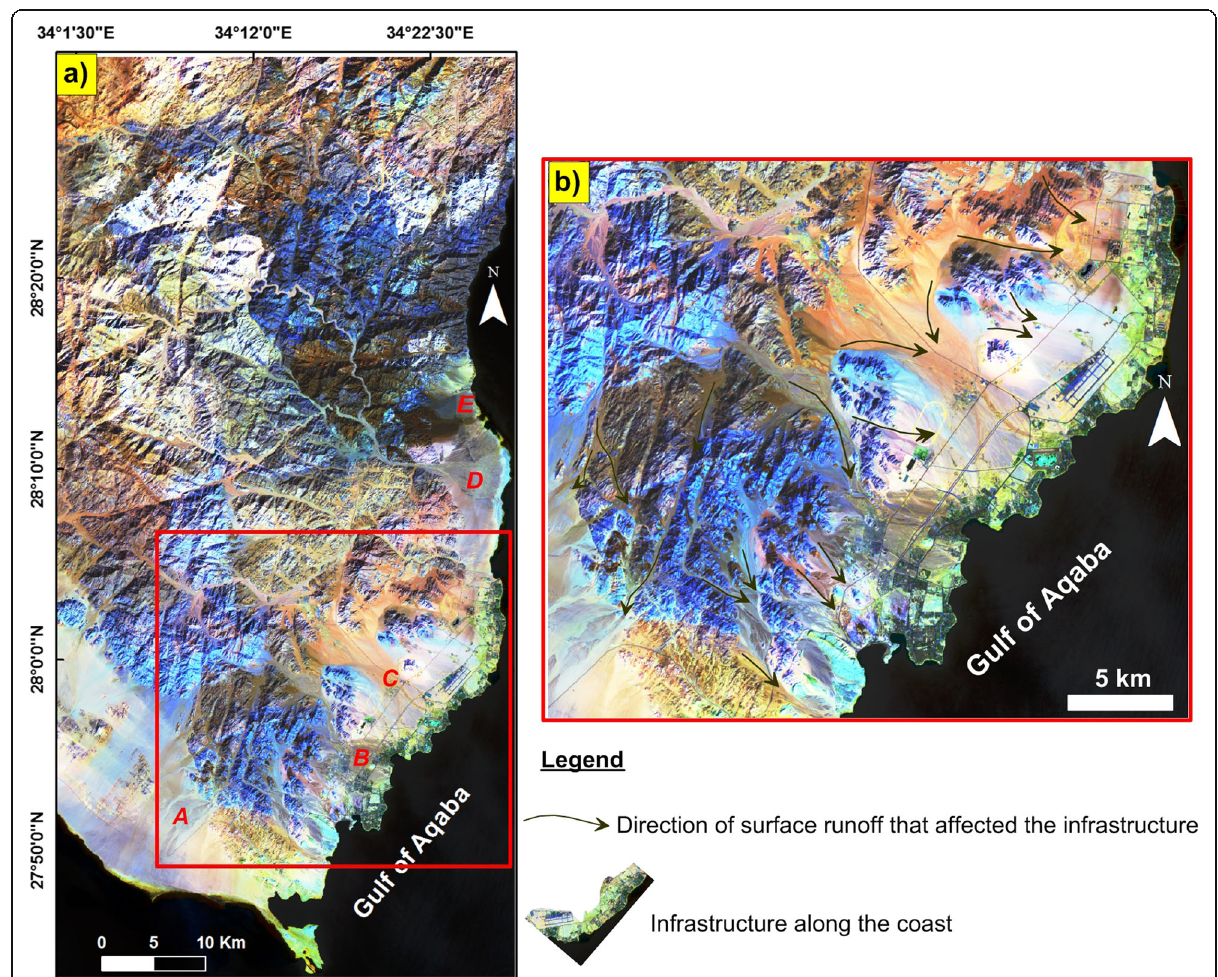
Fig. 5 a Band ratios image: 4/3, 6/2, and 7/4, for Landsat 8 to identify the different rock and sediments in correlation with their sources. The symbol (A) refers to the alluvial sediments of El Qaa plain (to the west of the study area) correlated with the alluvial fan deposits (symbols C and D) in the study area. The Miocene exposures (symbol B) is discriminated through band ratio layer than other alluvial sediment (A, C, and D), where they have limited distribution. b A close-up view on the infrastructure area of Sharm El Sheikh city (light green color) that directly affect